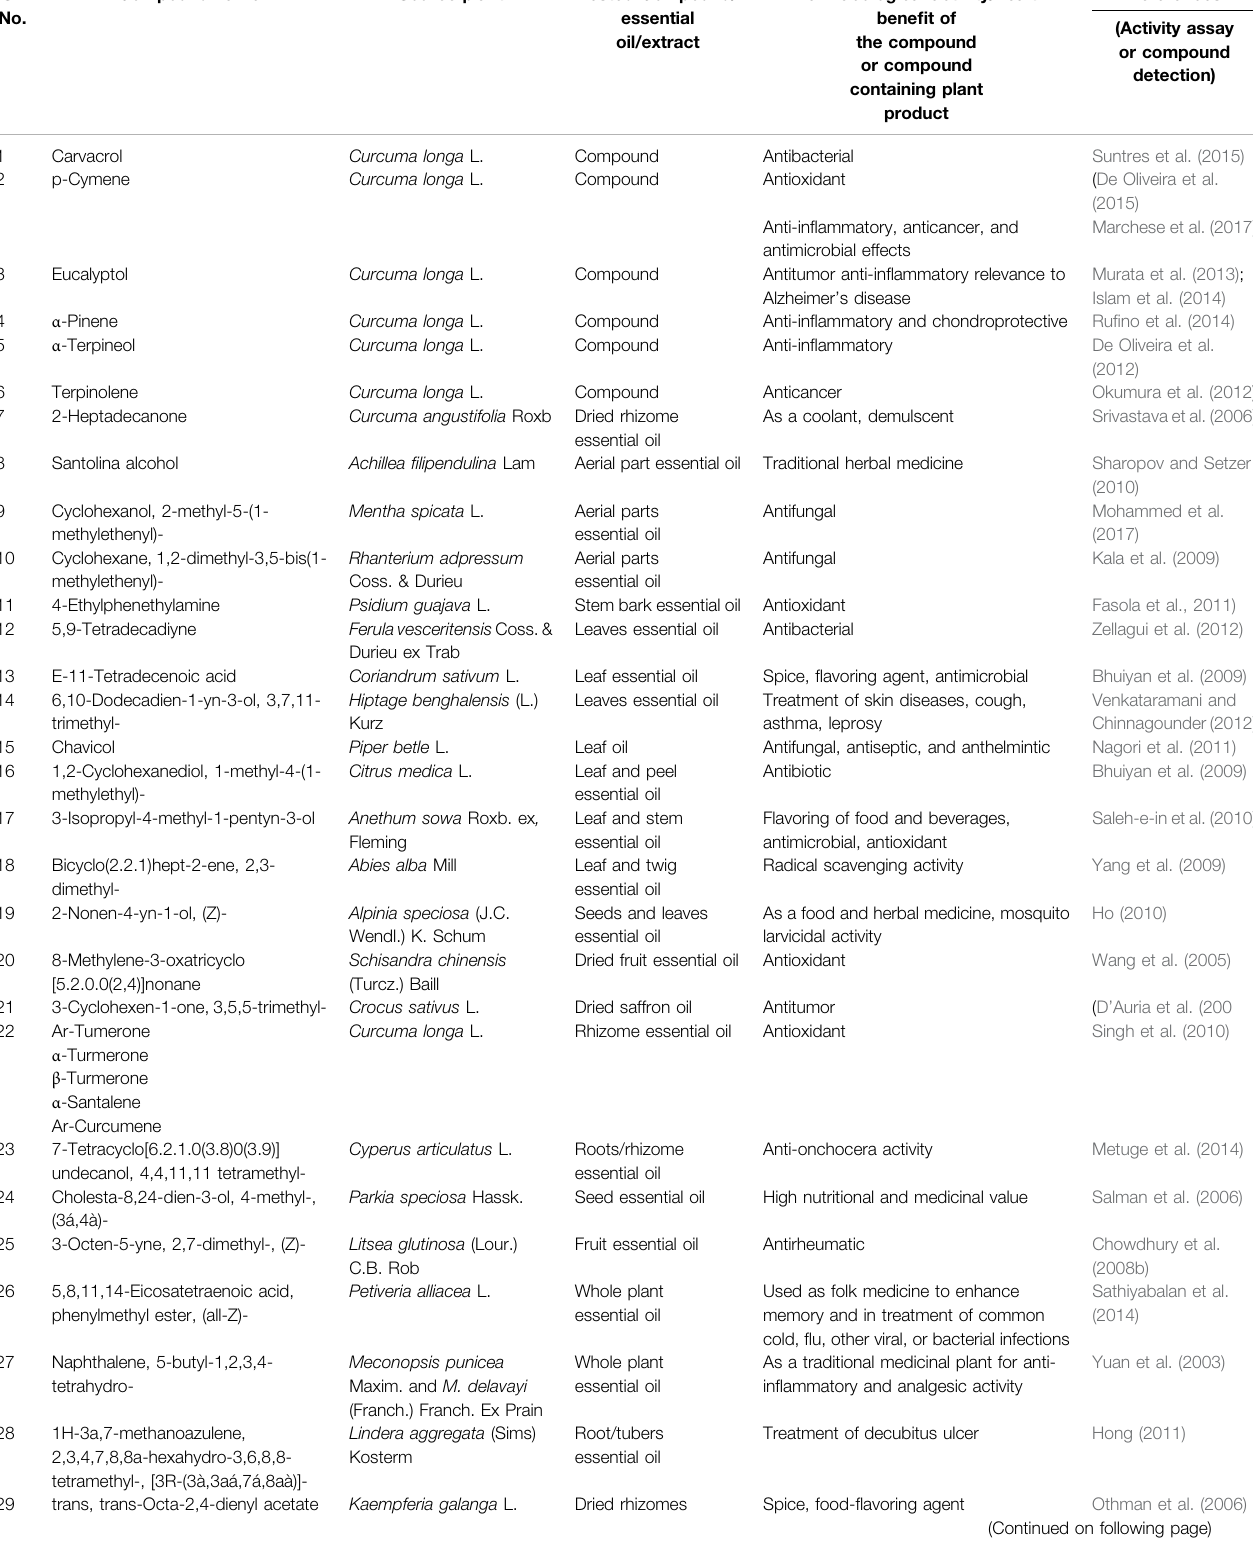
TABLE 9 | Pharmacological activity of metabolites identi fi ed, other than major curcuminoids (curcumin, demethoxycurcumin, and bisdemethoxy curcumin), in C. longa L. and C. aromatica Salisb. Sl.